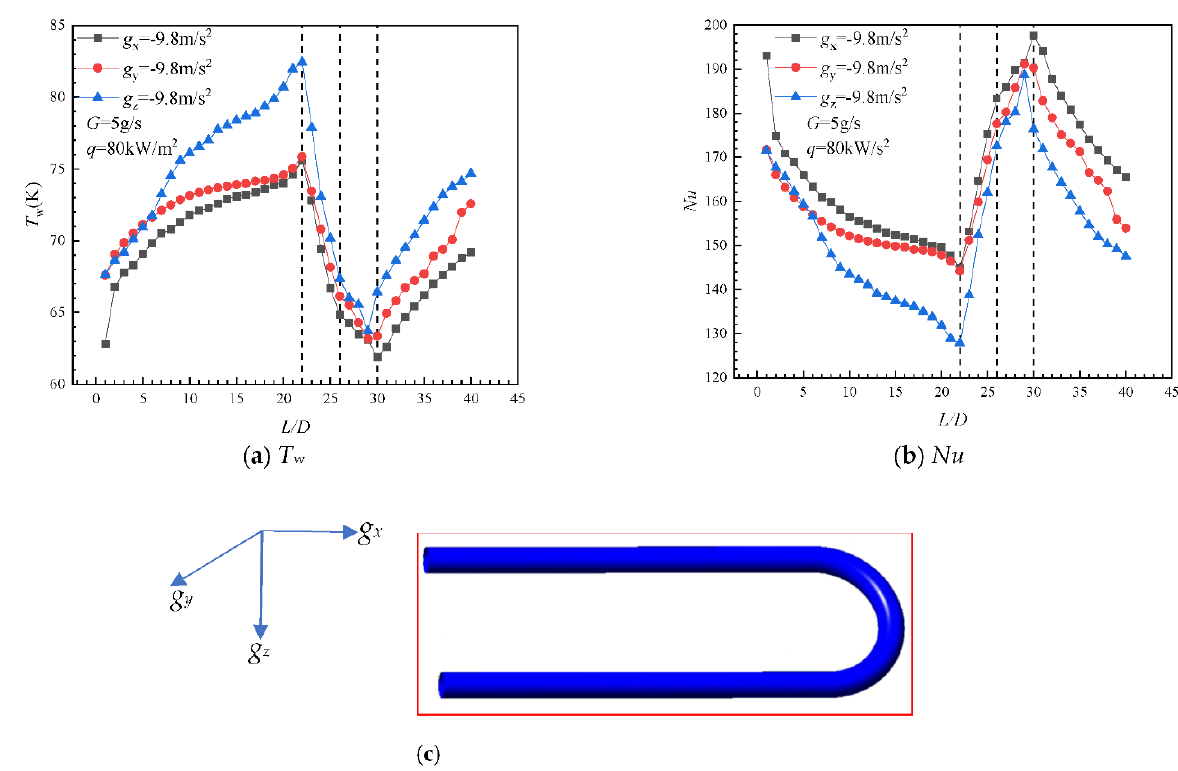
Figure 10. Variation of T w , Nu with L/D under different gravity directions and gravity direction diagram.